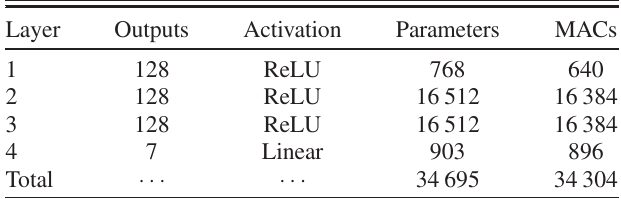
TABLE III. Implemented DQN MLP model architecture. The first NN layer receives five input